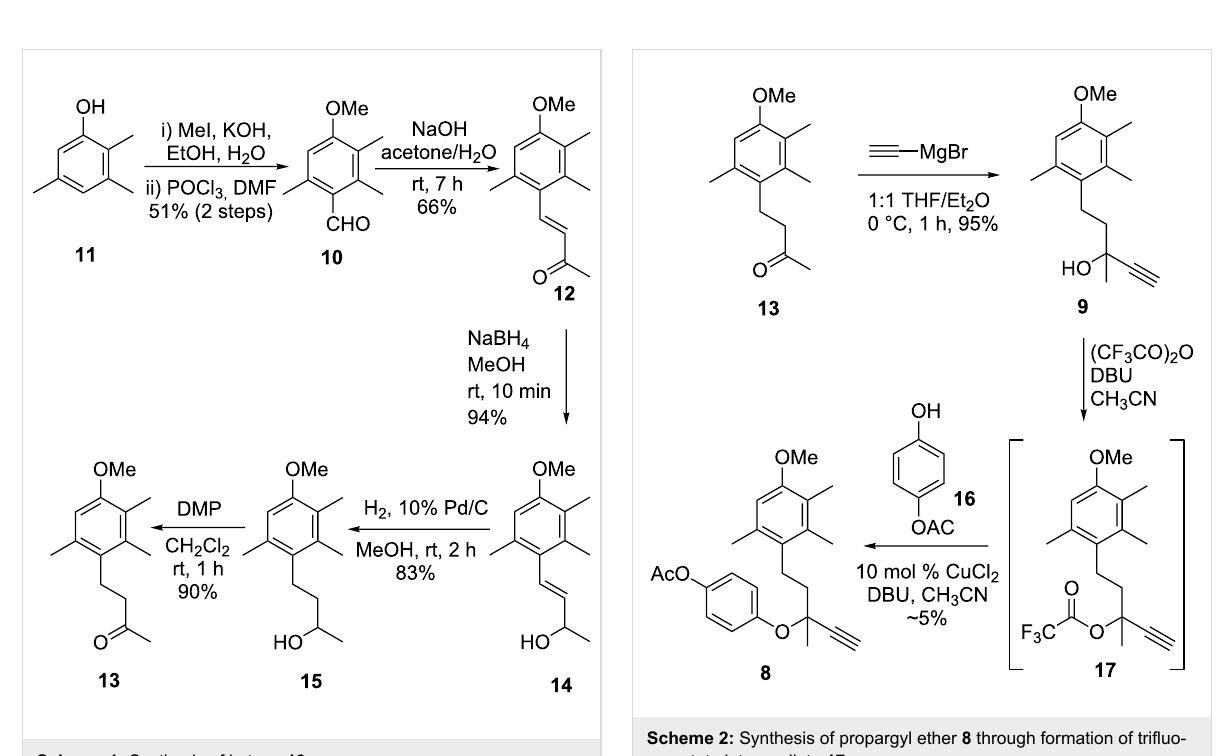
Scheme 1: Synthesis of ketone 13